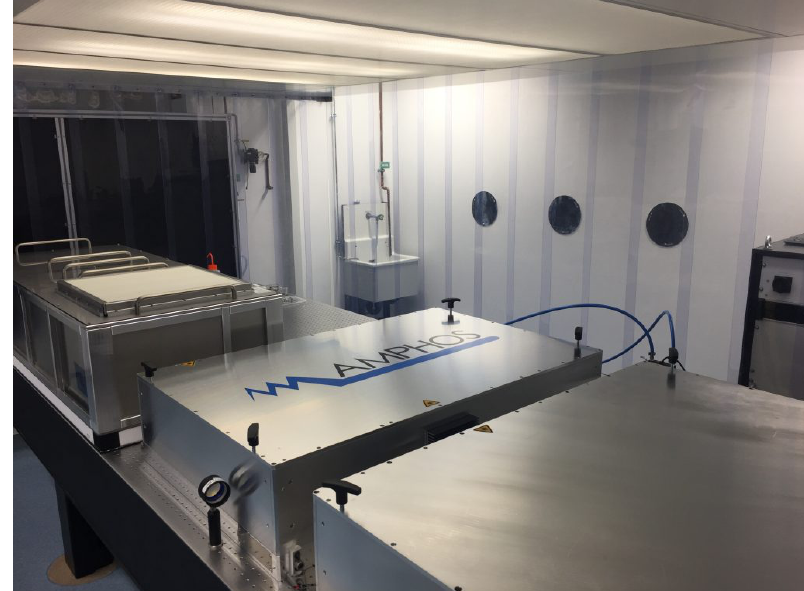
Figure 11: Photo of Ju SPARC_SIRIUS laser system. The high-power laser is operated under clean room conditions with multi-stage air filter systems, producing a low-turbulence laminar airflow to a create particle-free